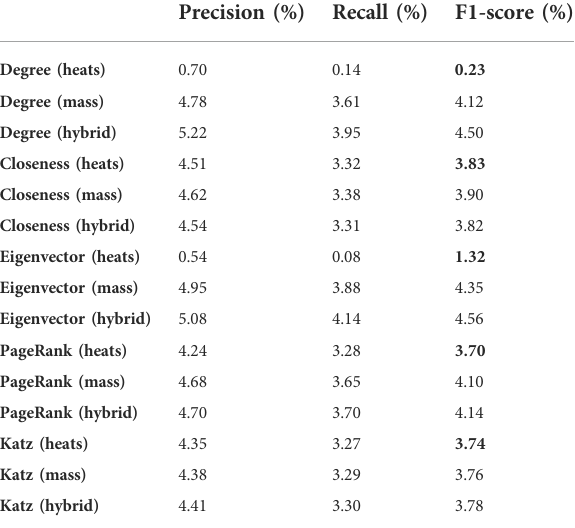
TABLE 4 Recommendation results adopting